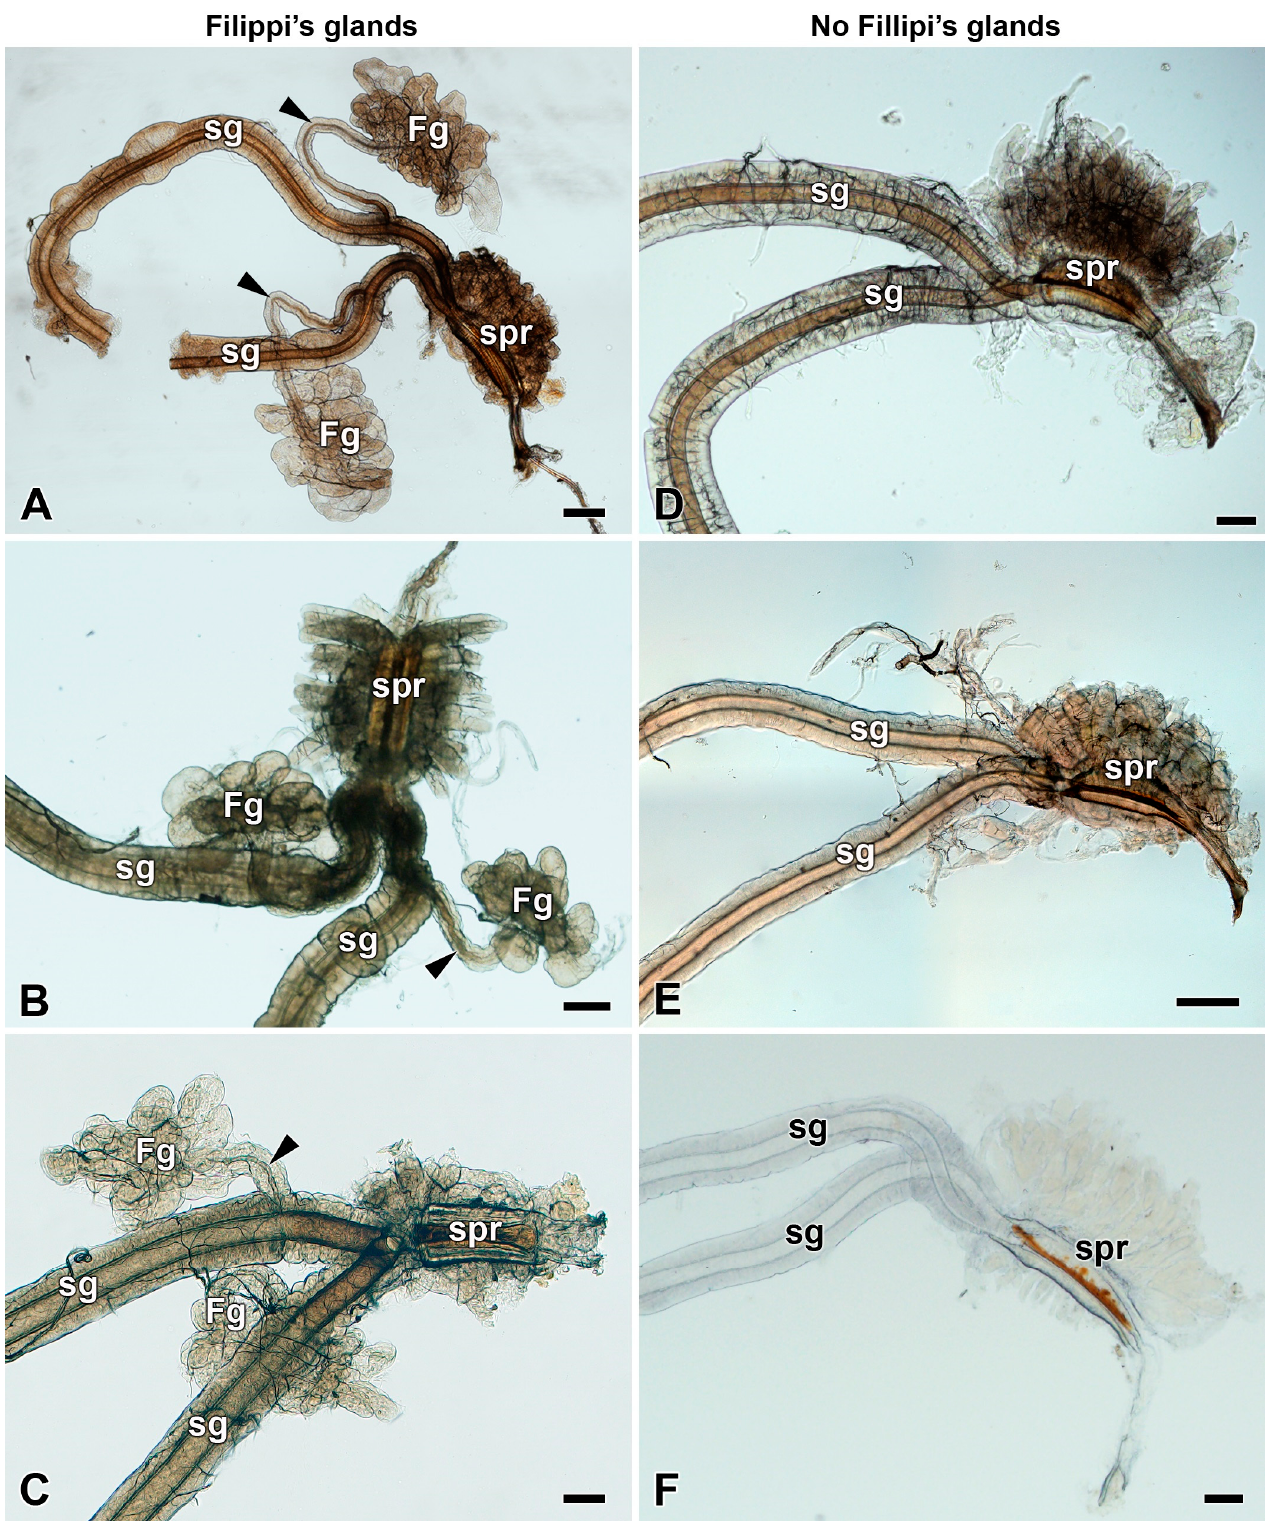
Figure 2. Spinning apparatuses of the 5th larval instar of Saturniidae. ( A ) The polyphemus moth, Antheraea polyphemus. ( B ) The Indian moon moth, Actias selene. ( C ) The small emperor moth, Saturnia pavonia. ( D ) The cecropia silk moth, Hyalophora cecropia. ( E ) The Eri silk moth, Samia cynthia. ( F ) The Atlas moth, Attacus atlas. Note that the FGs in H. cecropia , S. cynthia , and A. atlas are completely missing. The arrowheads indicate the ducts of the FGs entering the lumen of the SGs. Abbreviations: Filippi’s gland (Fg), silk gland (sg), and silk press of the spinning apparatus (spr). Scale bars: 100 μ m.